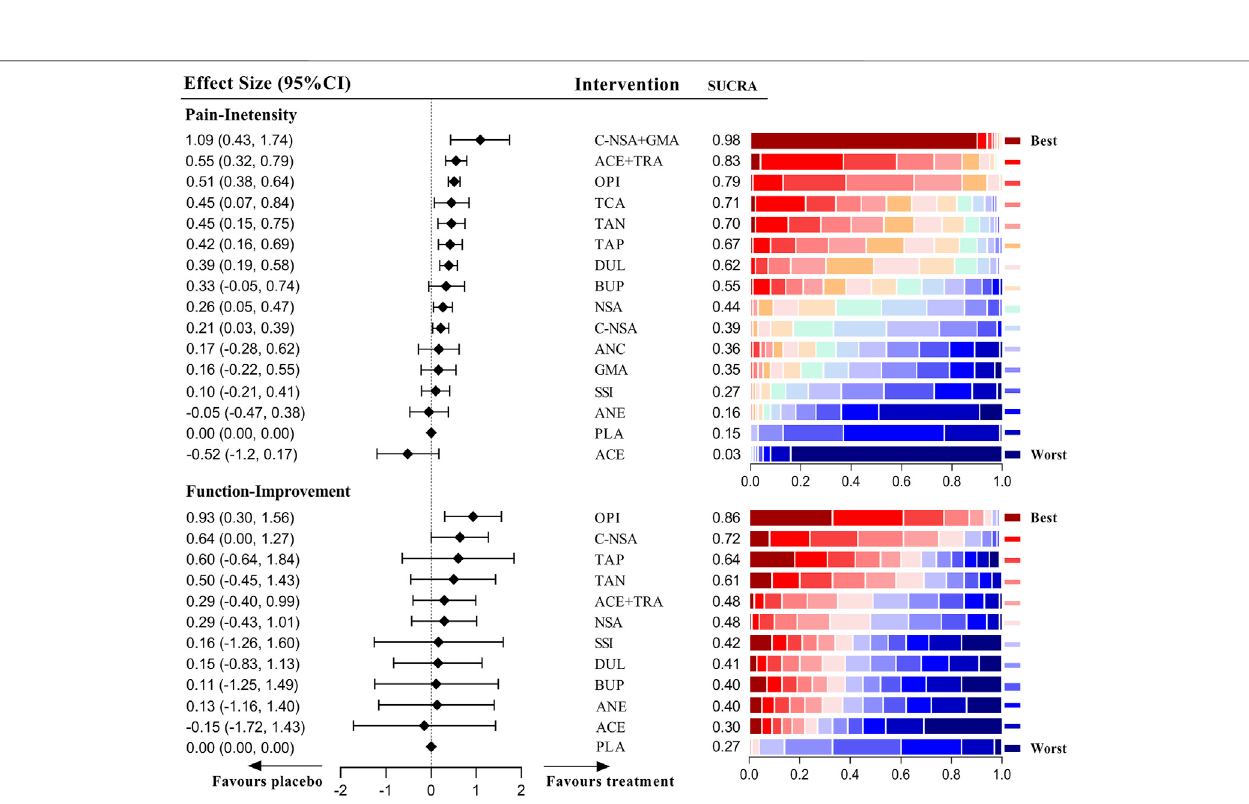
FIGURE 5 | Estimate effects and hierarchy of pharmacotherapies for chronic low back pain (LBP).